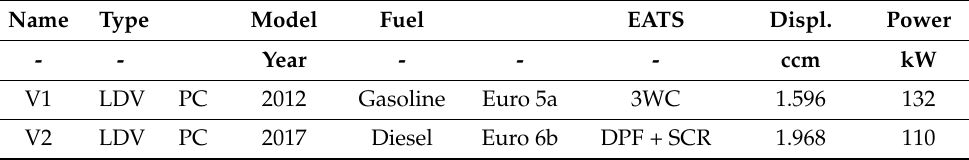
Table 1. Data of the vehicles used for the comparison